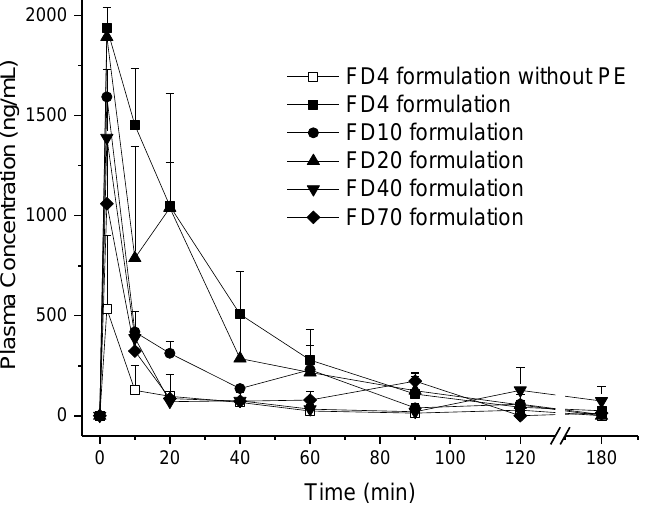
Figure 6. Plasma concentration versus time profiles of SFD particles loaded with FITC-labeled dextrans of different molecular weights with or without sodium taurocholate as a penetration enhancer after nasal administration in rats ( n = 3). Table 5. Pharmacokinetic parameters obtained for the various FITC-dextrans loaded SFDs. FD